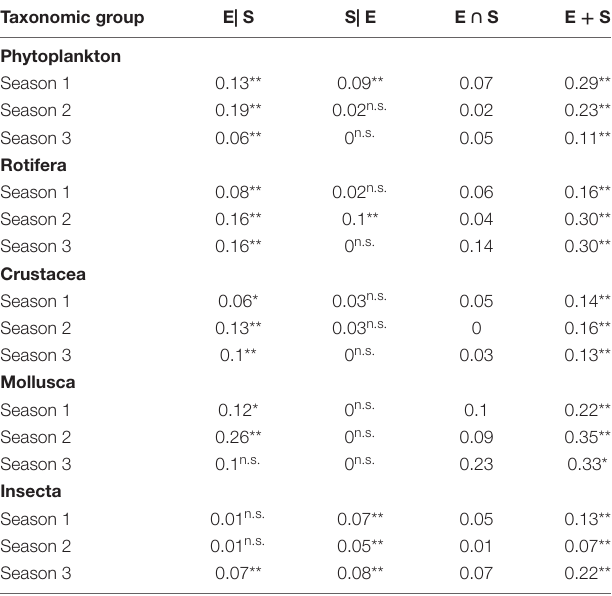
TABLE 3 | Results of variation partitioning analysis for Phytoplankton, Rotifera, Crustacea, Mollusca and Insecta, each sampling campaign analyzed separately, where E, environmental component; S, spatial